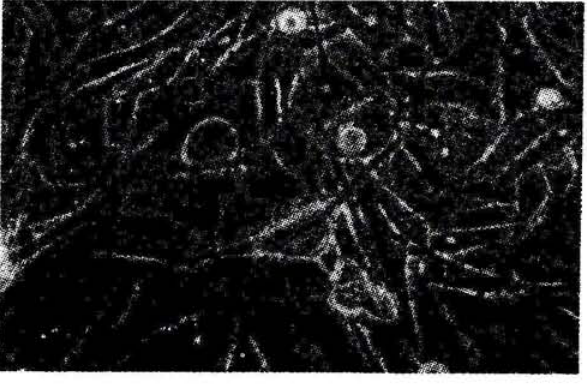
Figure 1. PC 12 cells after incubation with 50 ng NGF/ml medium and normoxic conditions (5% C0 2 and air) for eight